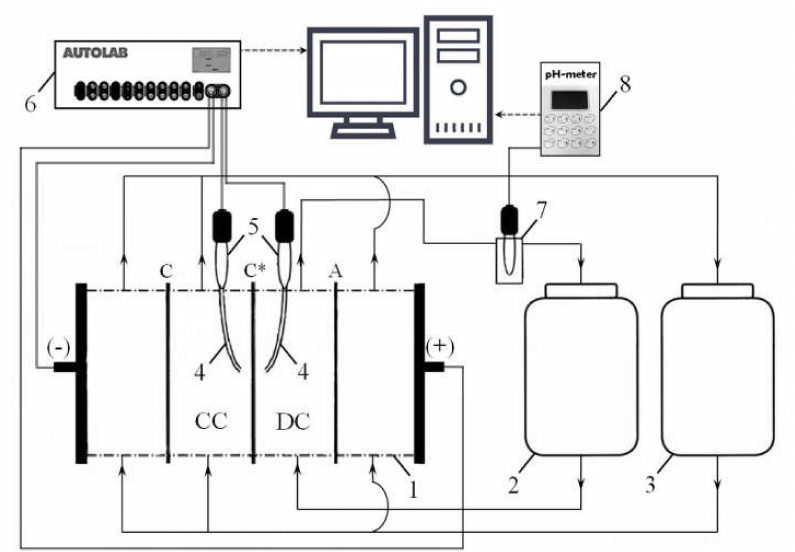
Figure 1. Principalschemeoftheexperimentalsetup: electrodialysiscell(1)consistingofonedesalination compartment (DC), one concentration compartment (CC) and two electrode compartments; tanks with solutions (2, 3); Luggin’s capillaries (4), connected with silver chloride electrodes (5); electrochemical complex Autolab PGSTAT-100 (6); flow pass cell with pH combination electrode (7), connected to pH-meter Expert 001